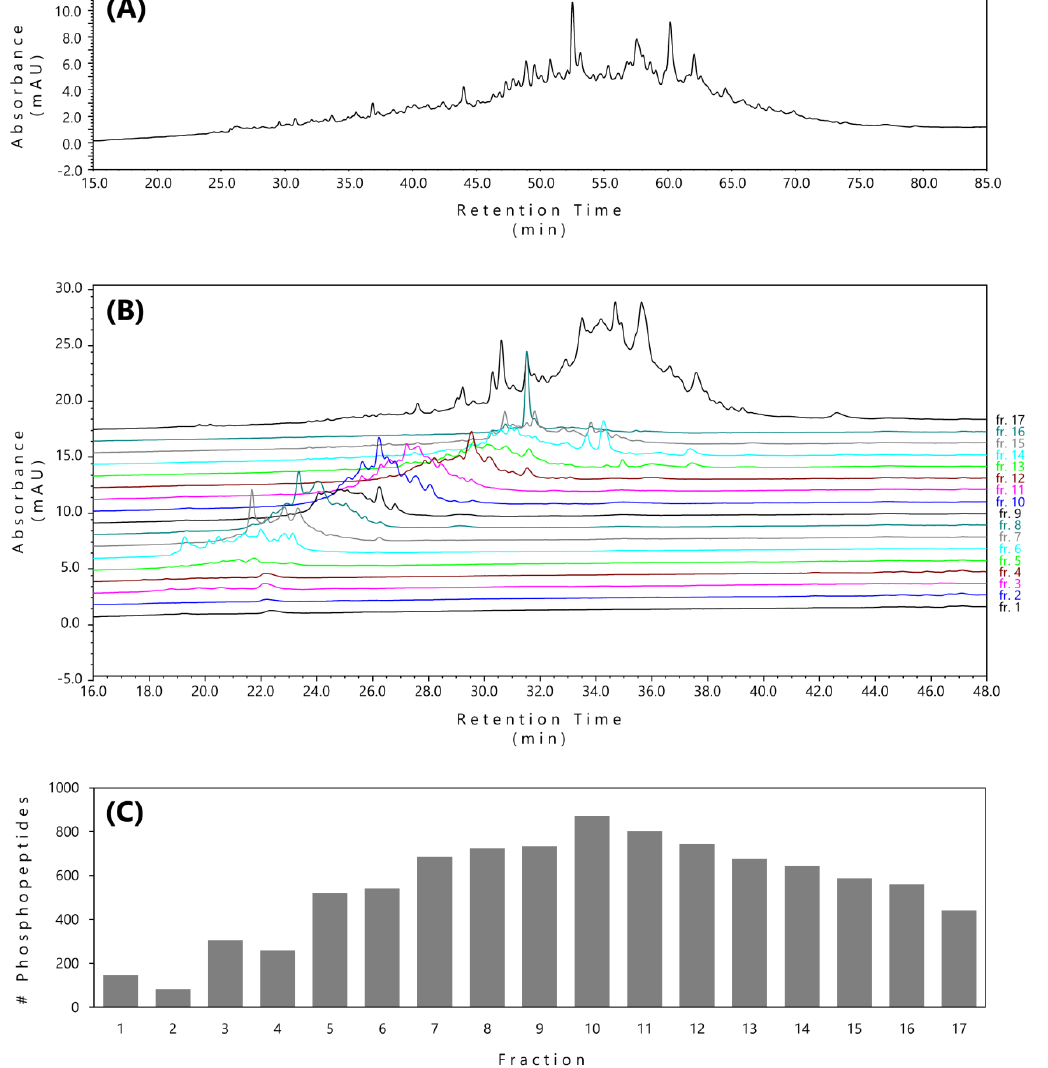
Figure 3. Comparison of the LC–UV chromatograms of purified ( A ) or fractionated ( B ) TiO 2 -enriched phosphopeptide sample obtained from trypsin-digested H1299 cell lysate. The fractionation scheme of the microgradient elution was optimized for a more uniform distribution of peptides throughout the elution fractions (see Table 1 for the detailed composition of the mobile phases used for phosphopeptide fractionation in the optimized elution scheme). Phosphopeptides identified using LC–MS / MS in each fraction were visualized as a histogram ( C